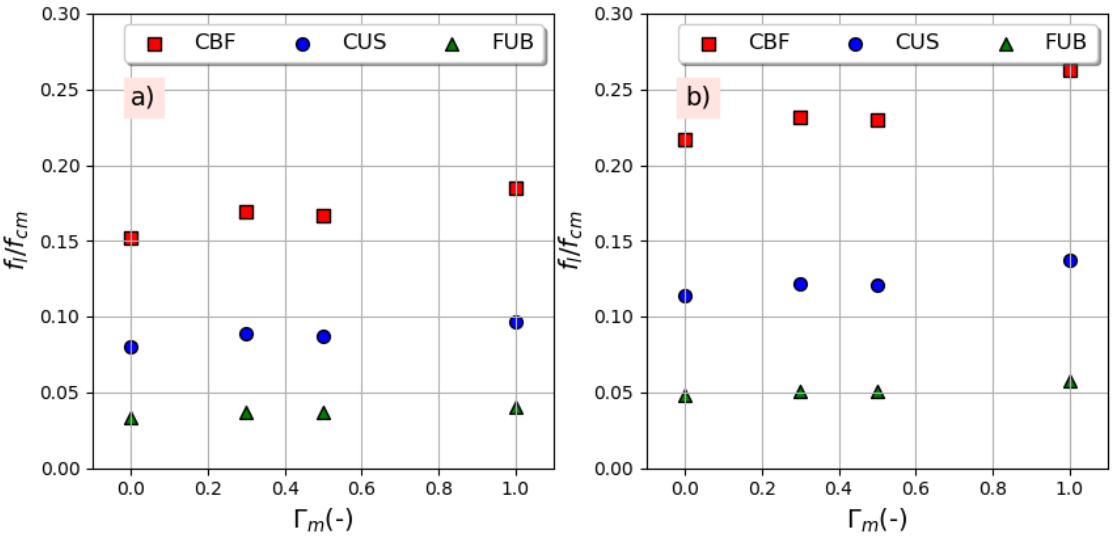
Figure 7. Confinement effectiveness with replacement ratio: ( a ) without air-entraining agent, ( b ) with 4% air-entraining agent.